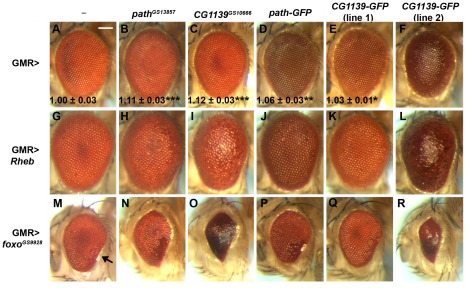

Drosophila PAT-GFP fusion proteins have similar functional activities to untagged PATs in vivo.Untagged transporters synthesised from GS insertions in path (pathGS13857; B, H, N) and CG1139 (CG1139GS10666; C, I, O), and tagged transporters synthesised from UAS-Path-GFP (D, J, P) and UAS-CG1139-GFP line 1 (E, K, Q) and line 2 (F, L, R) insertions were expressed in the differentiating cells of the fly eye with GMR-GAL4 in the presence or absence of other transgenes. (A–F) Overexpression of pathGS13857 (B) and CG1139GS10666 (C) produces a significant increase in ommatidial size relative to controls (A). A more subtle, but also significant, increase in growth was seen for PATH-GFP (D) and CG1139-GFP line 1 (E). CG1139 line 2 produced a bulging and disorganised eye phenotype (F). For size comparisons, n = 6; bottom of panels A–E, mean ± s.d. relative to control; * P<0.05, ** P<0.01, ***P<0.001. (G–L) The overgrowth induced by overexpressing UAS-Rheb with GMR-GAL4 (G) is synergistically enhanced by co-expression of tagged and untagged transporters (H–L), suggesting a role for Rheb signalling in controlling the growth-promoting activity of PATs. (M–R) The apoptotic, reduced eye phenotype produced by overexpression of foxoGS9928 with GMR-GAL4, which is most clearly seen at the ventro-posterior edge of the eye (arrow in M), is enhanced by co-expression of tagged and untagged transporters (N–R), consistent with these molecules acting through the TORC1 signalling cascade to inhibit Akt and enhance, FOXO activity. Scale bar is 100 µm and applies to all panels. Ommatidial size measurements were made when expression of transgenes did not disturb the ommatidial array.